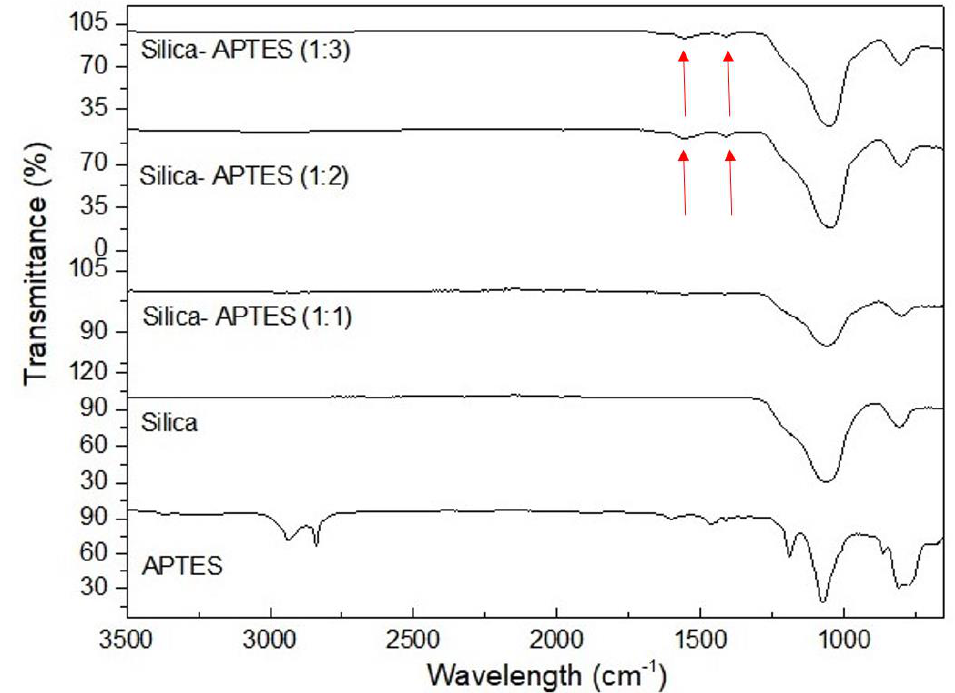
Figure 2. FTIR spectra of APTES, neat silica and APTES functionalized silica with three different ratios